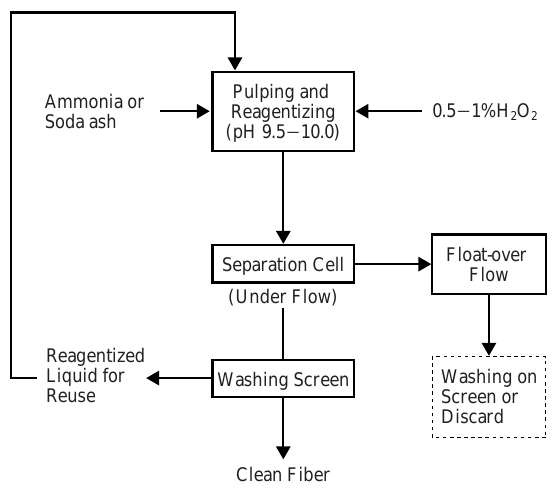
Flow Diagram of University of Florida (UF) Flotation De- inking